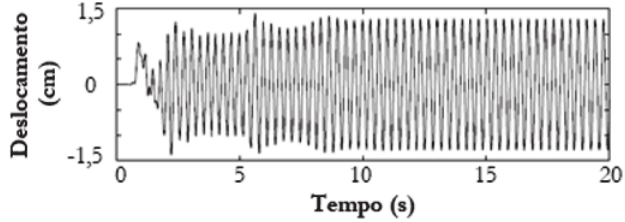
Figura 11 Deslocamento vertical do vértice da estrutura.